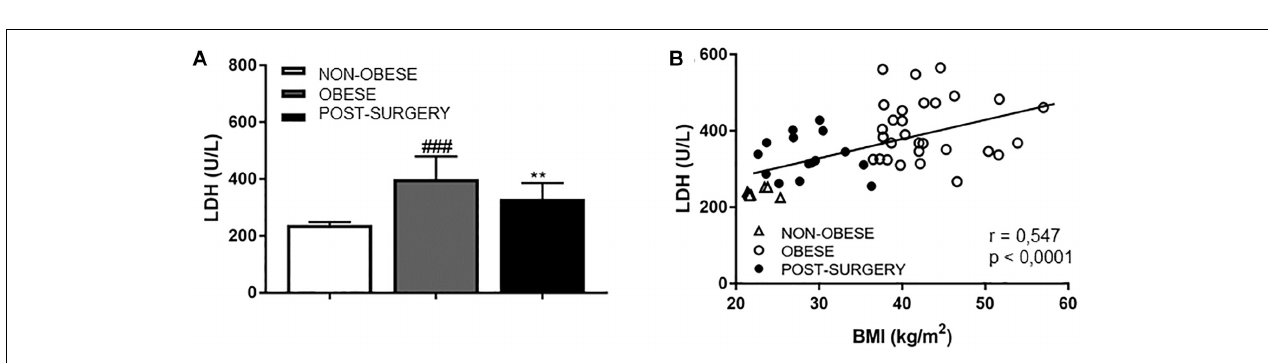
FIGURE 5 | (A) Representative cropped immunoblots of MMP-2 activity in plasma samples from non-obese, obese and Post-surgery patients. Diagram bars show the result of densitometric analysis of MMP-2 activity expressed as a percentage of MMP-2 activity in the non-obese group. (B) Representative cropped immunoblots of MMP-9 activity in plasma samples from non-obese, obese and Post-surgery patients. Diagram bars show the result of densitometric analysis of MMP-9 activity expressed as a percentage of MMP-9 activity in the non-obese group. (C) Correlation between MMP-9 activity and BMI. White triangles correspond to non-obese, white circles correspond to obese and black circles correspond to Post-surgery. Data are expressed as mean ± SEM of ≥ 7 determinations per group. ## p < 0.01 compared with the non-obese group. ∗ p < 0.05 and ∗∗∗ p < 0.001 compared with the obese group.